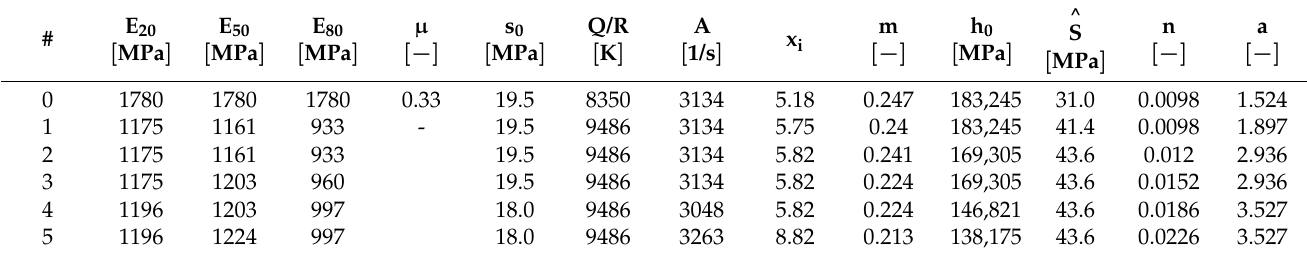
Table 3. Parameter values with three moduli of elasticity during identification.